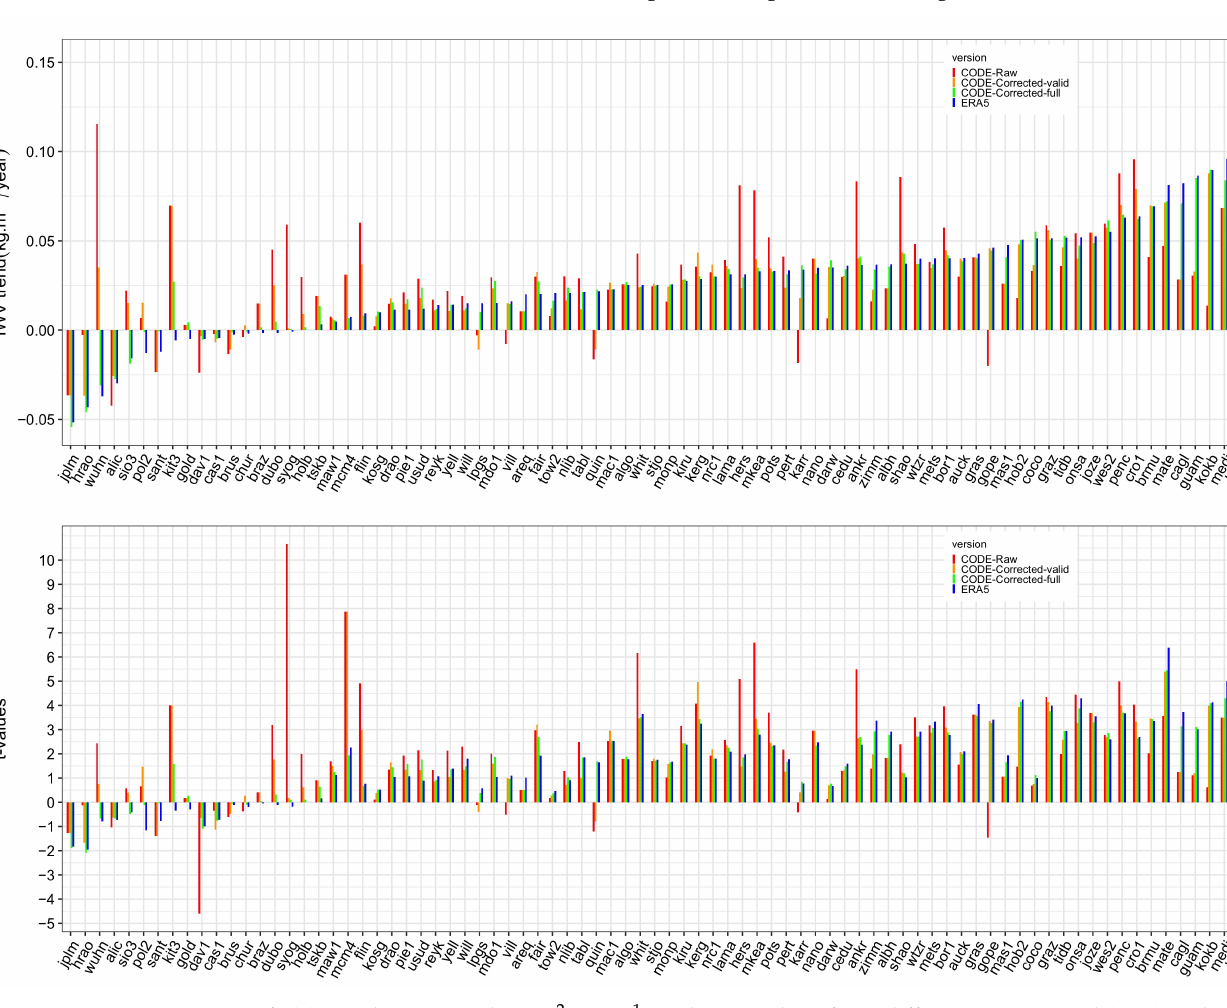
Figure 13. Comparison of: ( a ) trend estimates kg m − 2 year − 1 , and ( b ) t-values from different uncorrected (raw) and corrected GNSS data (CODE with auxiliary ERA5 and reference ERA5) and ERA5 at 81 common